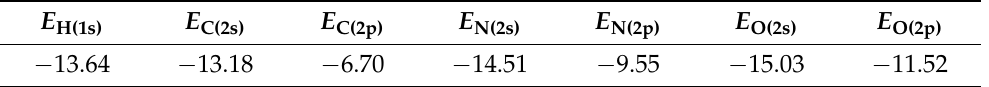
Table 1. Diagonal matrix elements also known as on-site energies, in our LCAO parameterization (eV).